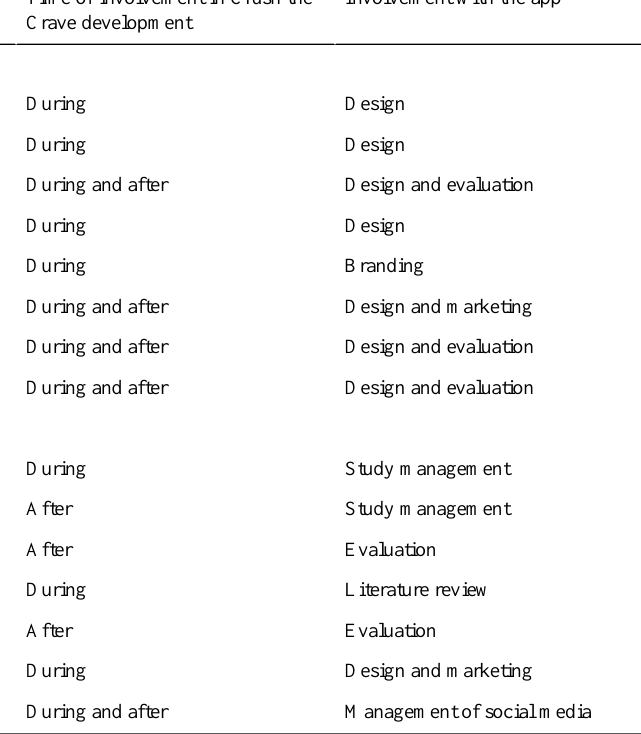
Involvement with the appTime of involvement in Crush the